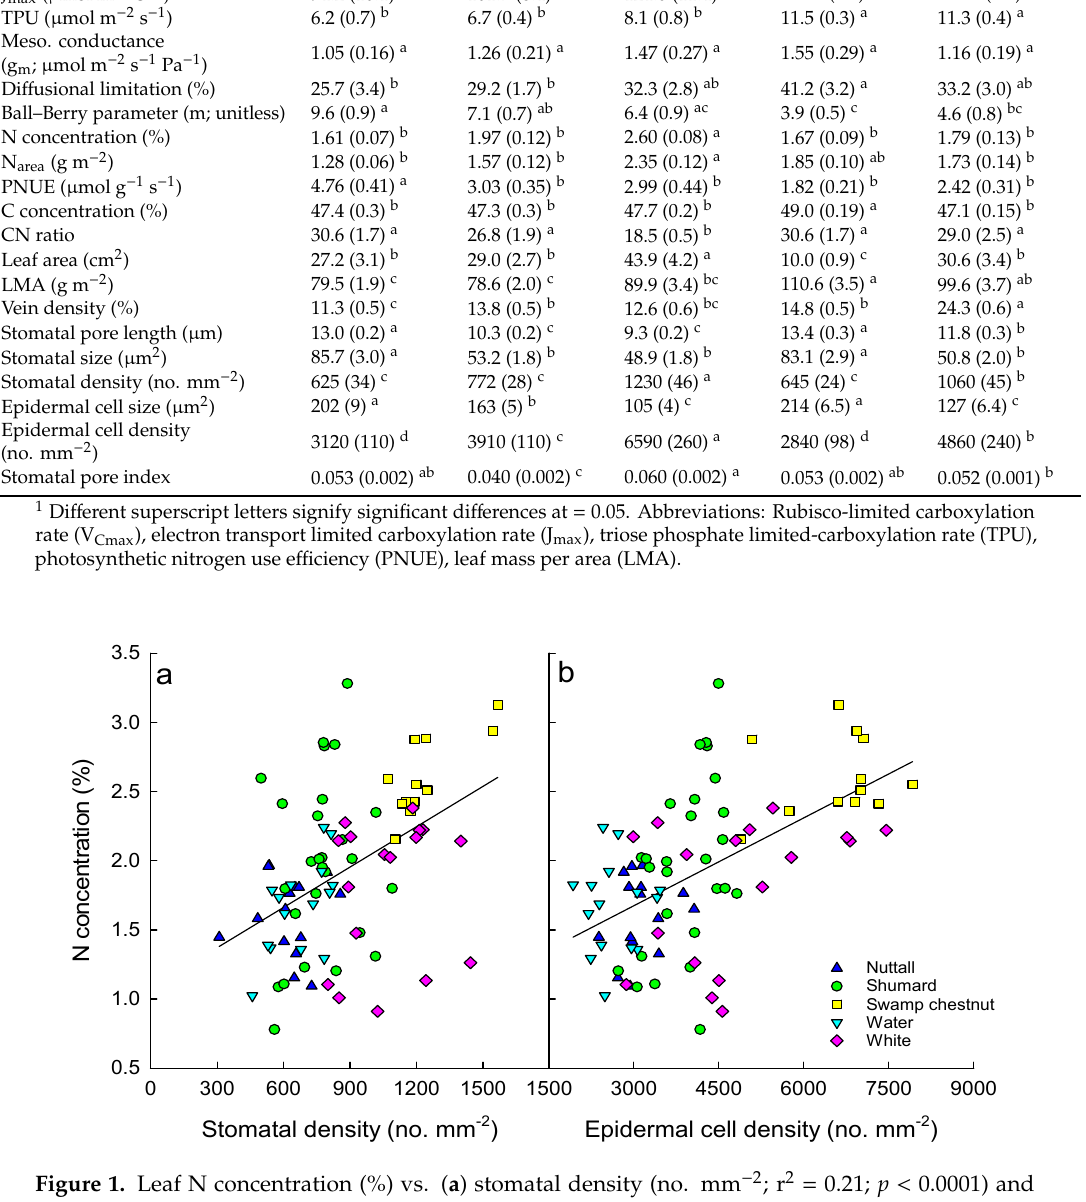
Figure 2. Photosynthetic nitrogen use efficiency (PNUE; μ mol g − 1 s − 1 ) vs. ( a ) instantaneous water use efficiency estimated from gas exchange data (water use efficiency (WUE); μ mol mmol − 1 ; r 2 = 0.36; p < 0.0001) and ( b ) diffusional limitation to photosynthesis (%; r 2 = 0.18; p < 0.0001) for Nuttall (dark blue, up triangle), Shumard (green circle), swamp chestnut (yellow square), water (light blue down triangle), and white oak (magenta diamond). Individual leaf sizes varied fourfold across the measured oaks and LMA differed by about 40% across oak species (Table 2). Across all measured oaks, LMA was linearly and positively correlated